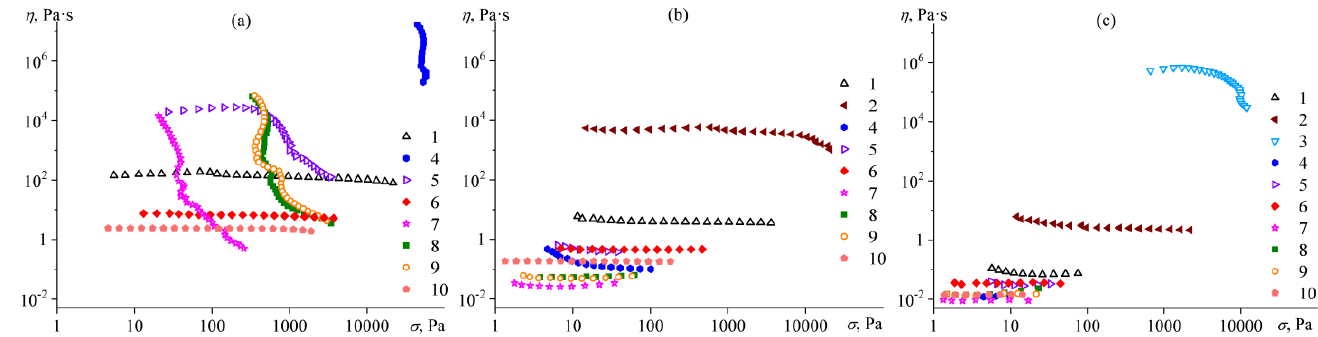
Figure 7. Dependences of effective viscosity on shear stress for bitumens at 25 °C ( a ), 60 °C ( b ), and 135 °C ( c ). Bitumen numbers are indicated in the legends.